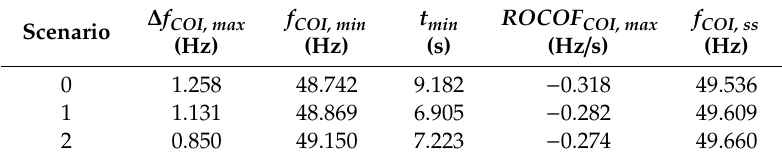
Table 12. Frequency response indicators of Scenario 0, Scenario 1 and Scenario 2 in the year